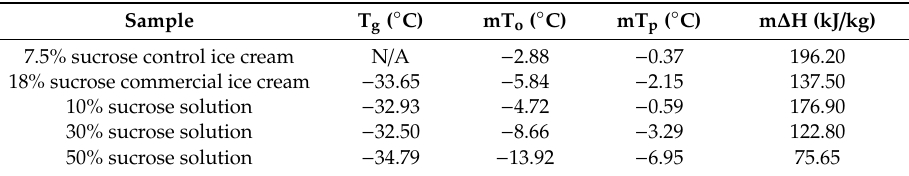
Table 2. Results of control ice cream, commercial ice cream, sugar solution of at 10, 30, and 50% sucrose by DSC analyses for heating from − 60 to 30 ◦ C with the heating rate 6 / ◦ C min.